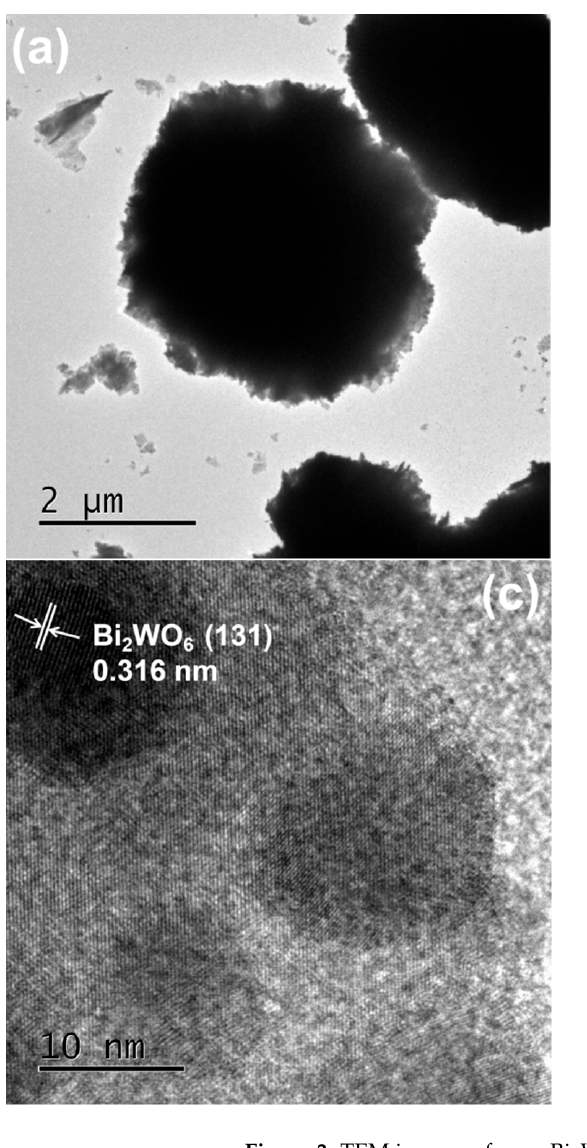
Figure 3. TEM images of pure Bi 2 WO 6 ( a ) and 2%Sn-Bi 2 WO 6 ( b ), HRTEM images of pure Bi 2 WO 6 ( c ) and 2%Sn-Bi 2 WO 6 ( d ).